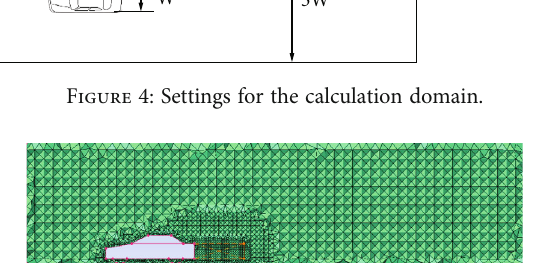
Figure 5: Fluent model